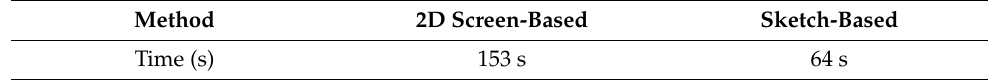
Table 4. Average time to create environment.